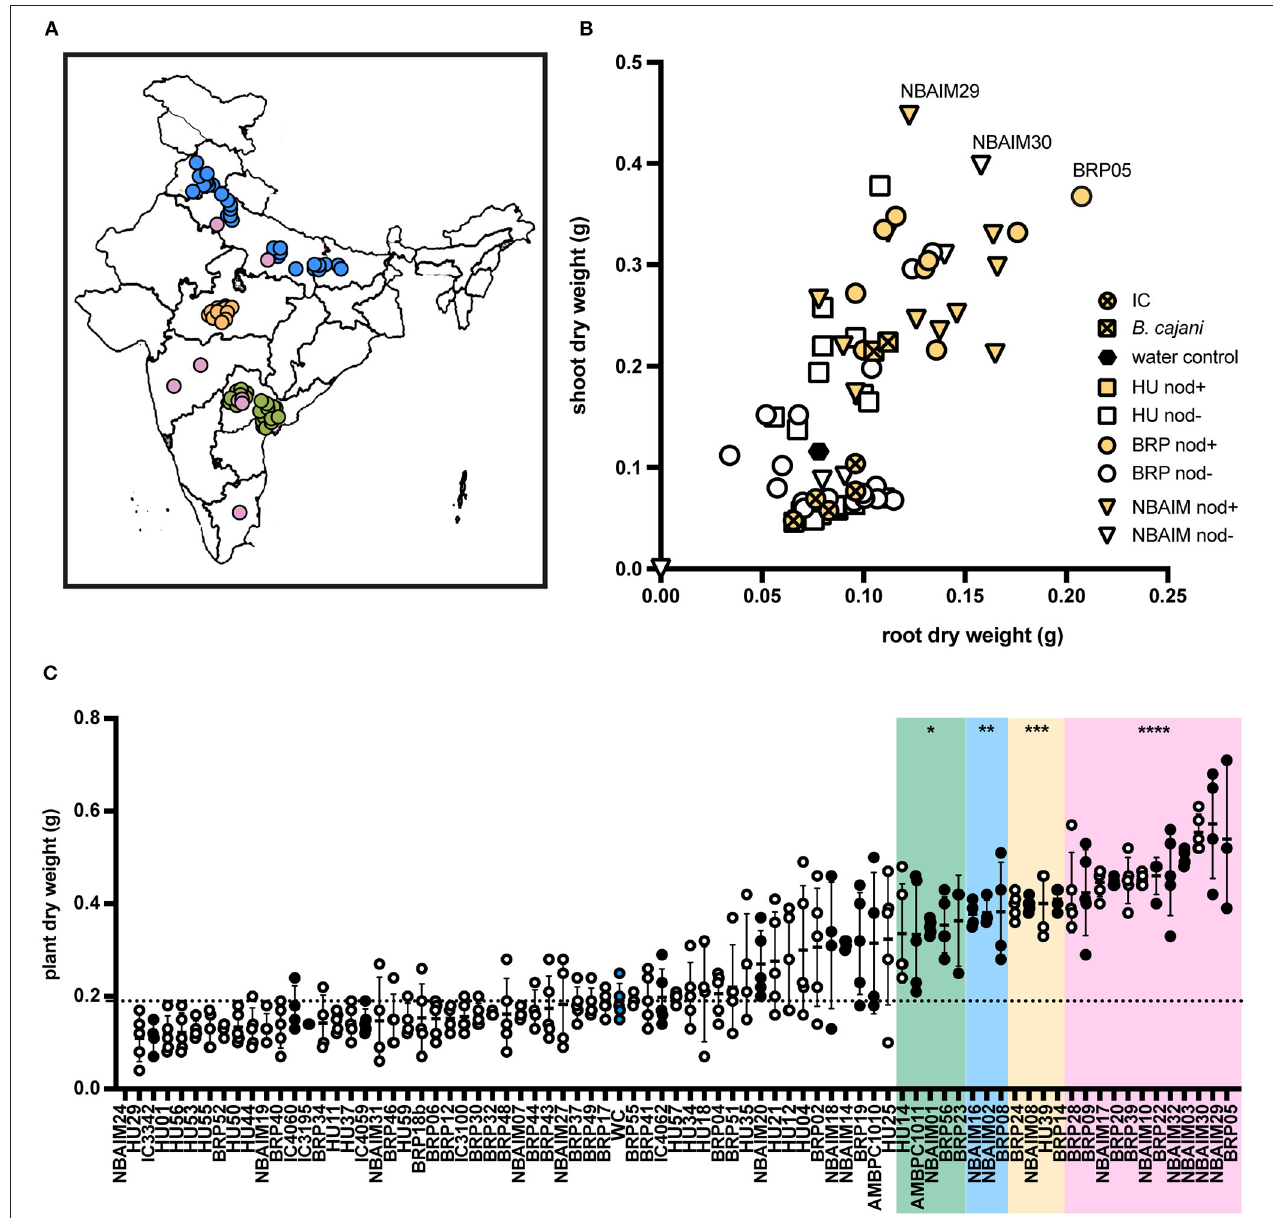
FIGURE 1 | Isolation location and effect of bacterial inoculation on pigeon pea ( Cajanus cajan L. Millsp.) of all India-UK (IU) strains and ICRISAT (IC) strains. (A) Map of India with isolation location for all IU and IC strains. In green, strains isolated by the University of Hyderabad (HU), yellow by ICAR-Indian Institute of Soil Science (BRP), blue by ICAR-National Bureau for Agriculturally Important Microorganisms (NBAIM), and pink ICRISAT pigeon pea reference strains. (B) Mean of dry weights of root (X-axis) and shoot (Y-axis) of C. cajan plants, following inoculation with bacterial strains. B. cajani reference strains AMBPC1010 T and AMBPC1011 are represented by crossed squares, IC strains by crossed circles, HU isolates by squares, BRP isolates as circles, and NBAIM isolates as triangles. White symbols represent non-nodulating strains (nod-), and yellow symbols show nodulating strains (nod + ) under controlled conditions. (C) Mean plant dry weight for each strain. White circles represent nod- strains, black circles nod + , and blue circles water control. A horizontal dashed line represents the water control dry weigh average. One-way ANOVA analysis ( F = 15.43, R 2 = 0.8076, p < 0.0001) was performed followed by Sidak’s post-hoc test. Asterisks represent a significance level vs. water control (WC) (* p < 0.05, ** p < 0.01, *** p < 0.005, and **** p <